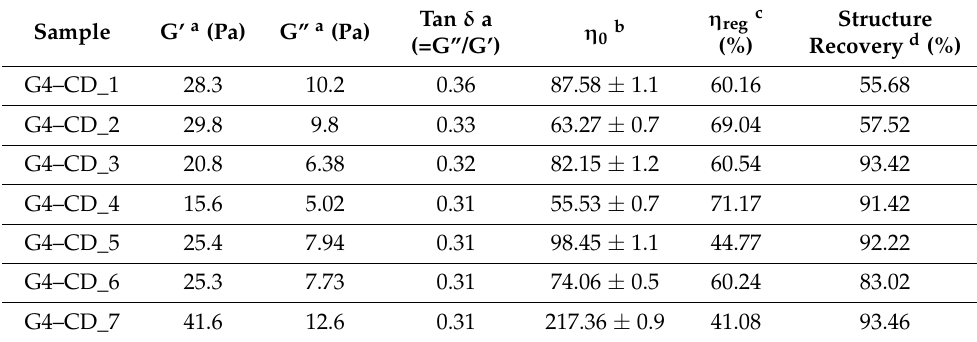
Table 1. Rheological parameters of the investigated